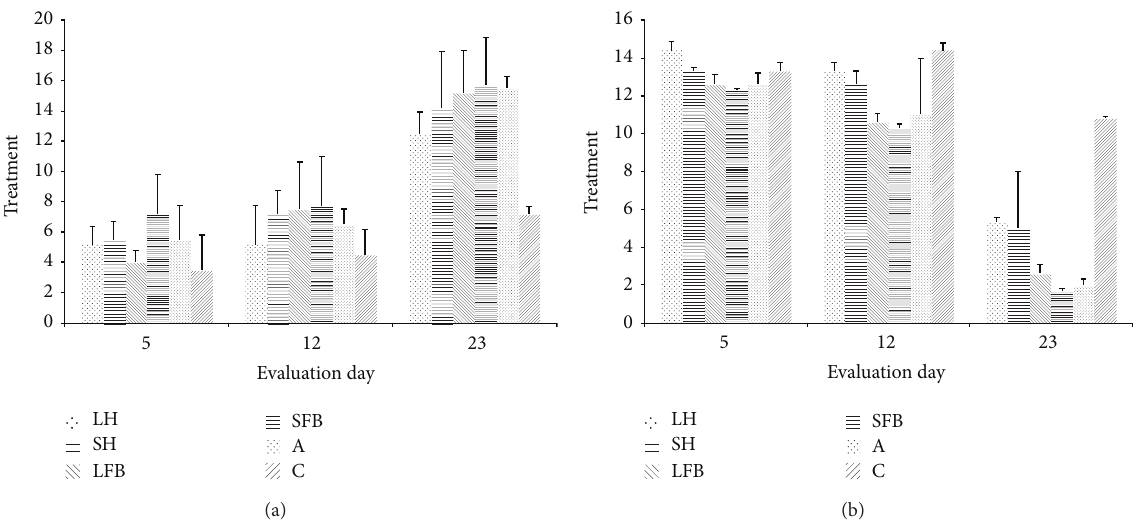
Figure 1: (a) Macroscopic evaluation of healing using WBS scale score on days 5, 12, and 23. (b) Macroscopic evaluation of healing using PUSH scale score on days 5, 12, and 23. LH: Lucilia sericata haemolymph-derived larval therapy, SH: Sarconesiopsis magellanica haemolymph- derived larval therapy, LFB: Lucilia sericata fat body-derived larval therapy, SFB: Sarconesiopsis magellanica fat body-derived larval therapy, A: antibiotic, and C: